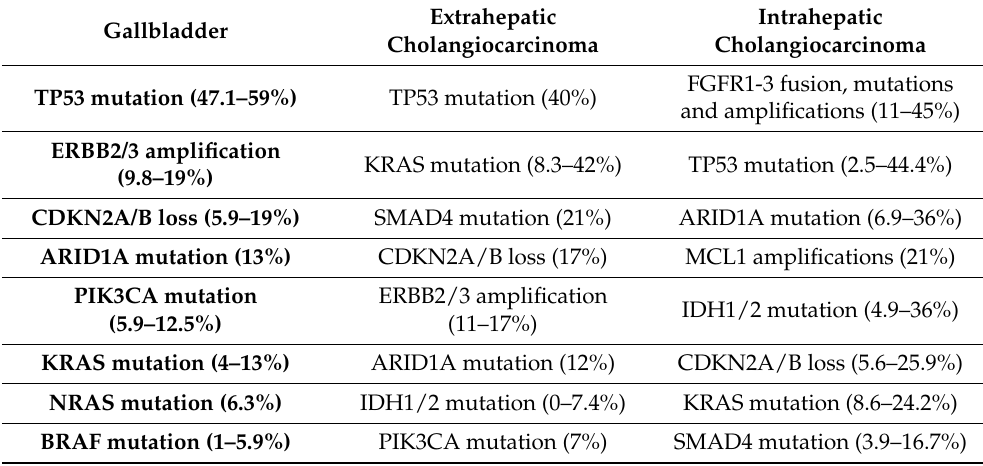
Table 2. The frequency of the most frequent genetic aberrations in targetable pathways of interest in BTC. The frequencies were based on the publication of Valle J.W. et al. (Cancer Discovery, 2017) [107]. Abbreviations: GB—gallbladder; IHCC—intrahepatic cholangiocarcinoma; EHCC—extrahepatic